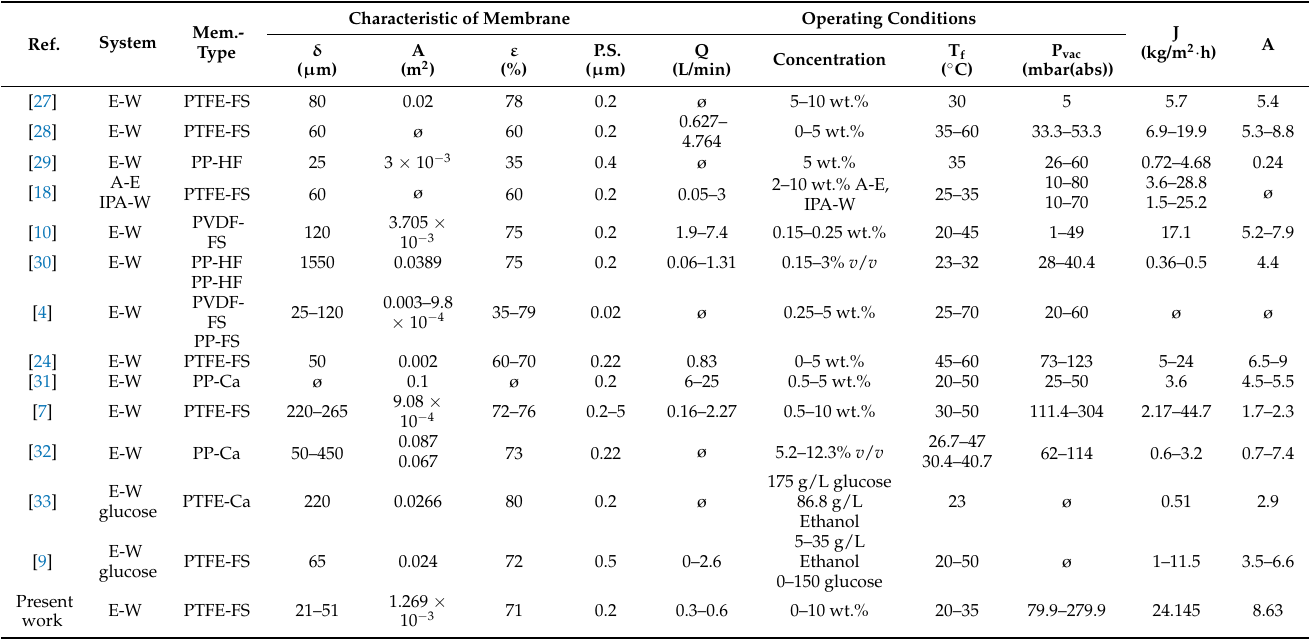
Table 2. Comparison study on the operating conditions and permeate flux obtained by the current work with several studies presented in the literature by using VMD in various types of membranes.